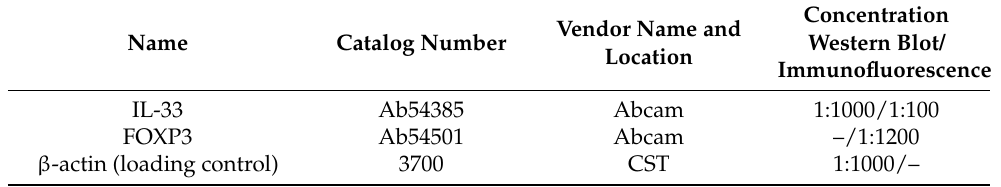
Table 3. List of antibodies used in the Western blot and immunofluorescence